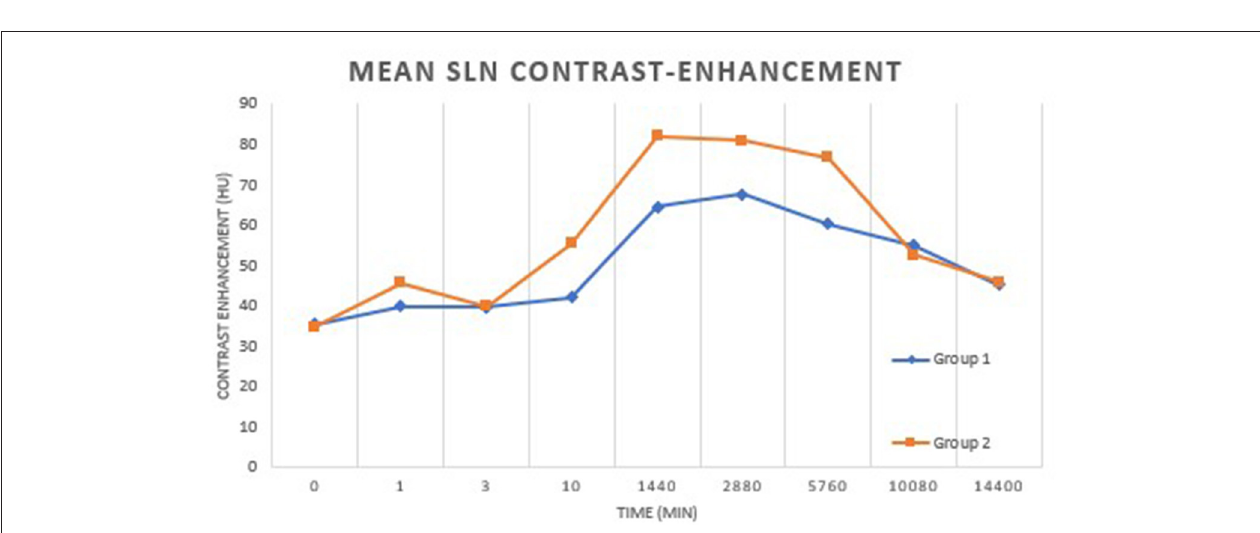
FIGURE 4 | The overall peak mean contrast enhancement of the SLNs was 73.98 HU at 2 days post-injection. There was a significant difference in SLN contrast enhancement at each time point compared to baseline ( p < 0.01). There was no significant difference identified between groups ( p = 0.71).